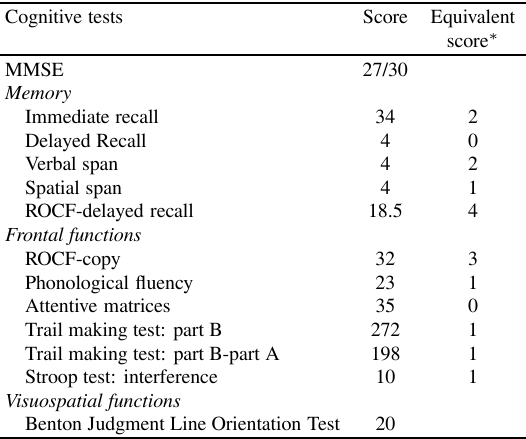
Table 1 Formal neuropsychological